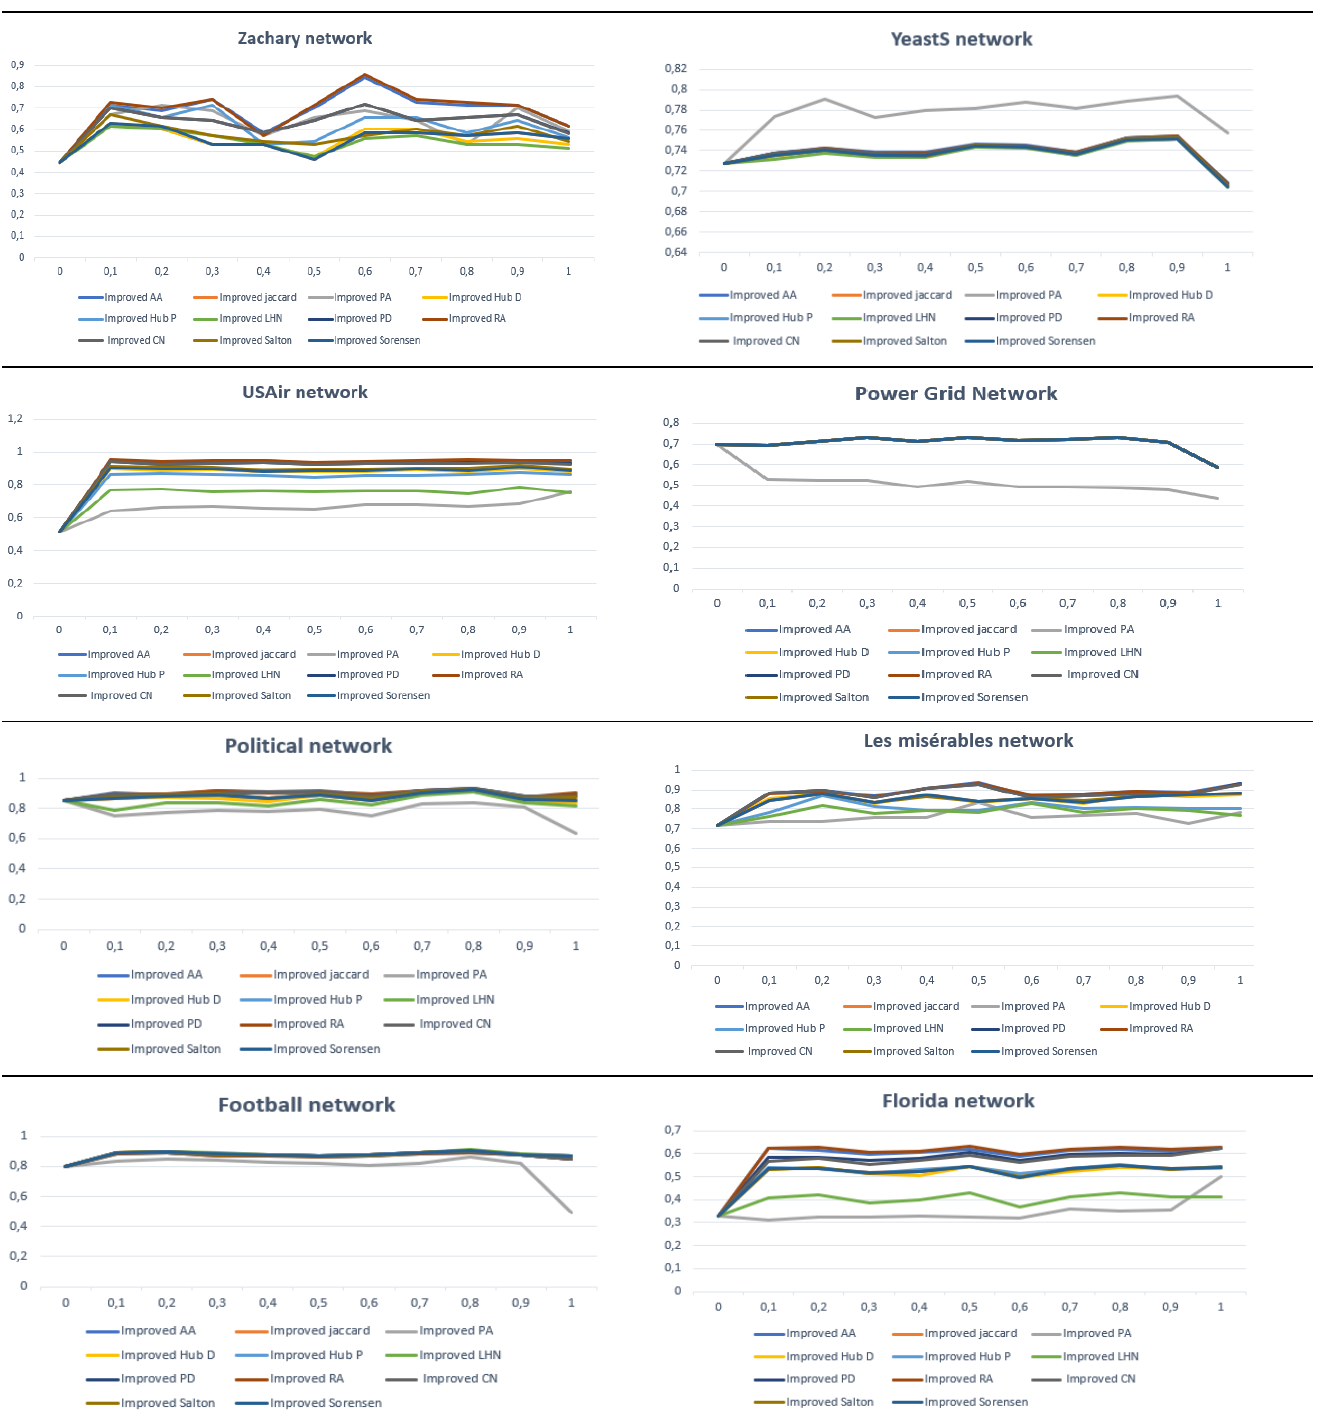
Table 3. x axis represents the values of α and the y axis represents the values of AUC using Equation (13).